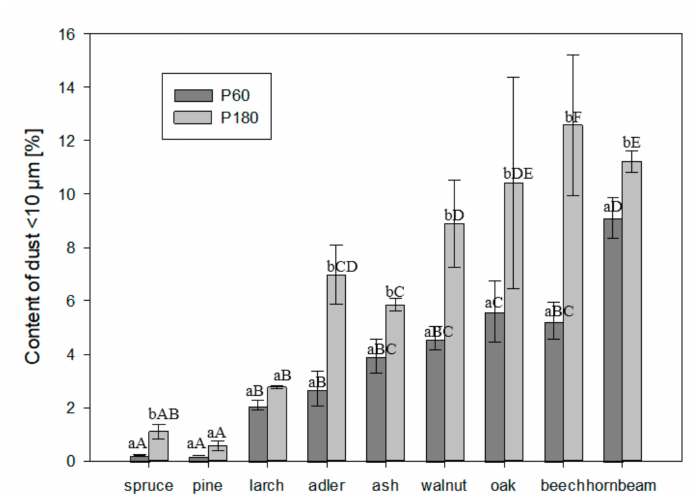
Figure 4. Analysis of the content of the finest dust particles; a, b: the same letters indicate no significant di ff erences at the significance level of 0.05 between sandpaper grit sizes; A, B: the same letters indicate no significant di ff erences at a significance level of 0.05 between wood species.